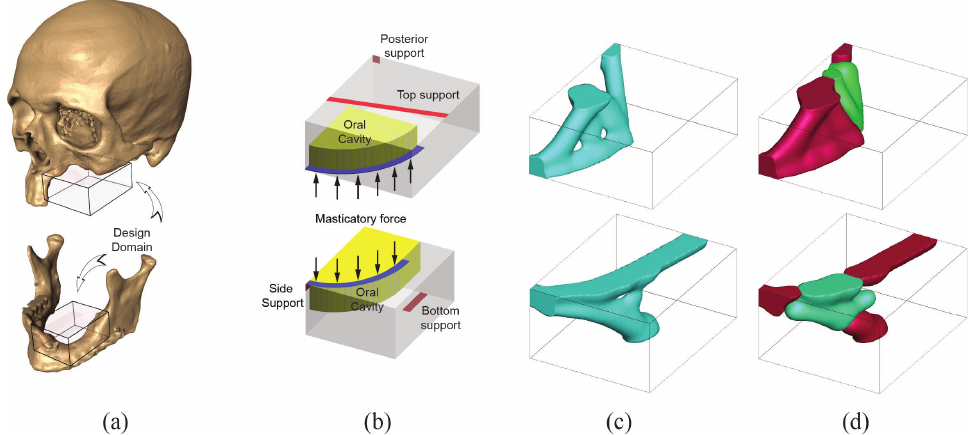
Figure 10. Case 4. ( a ) Design domain extraction from patient CT scan, ( b ) boundary condition used in the analysis, ( c ) bone replacement shapes using single material topology optimization, ( d ) bone replacement shapes using two material topology optimization.